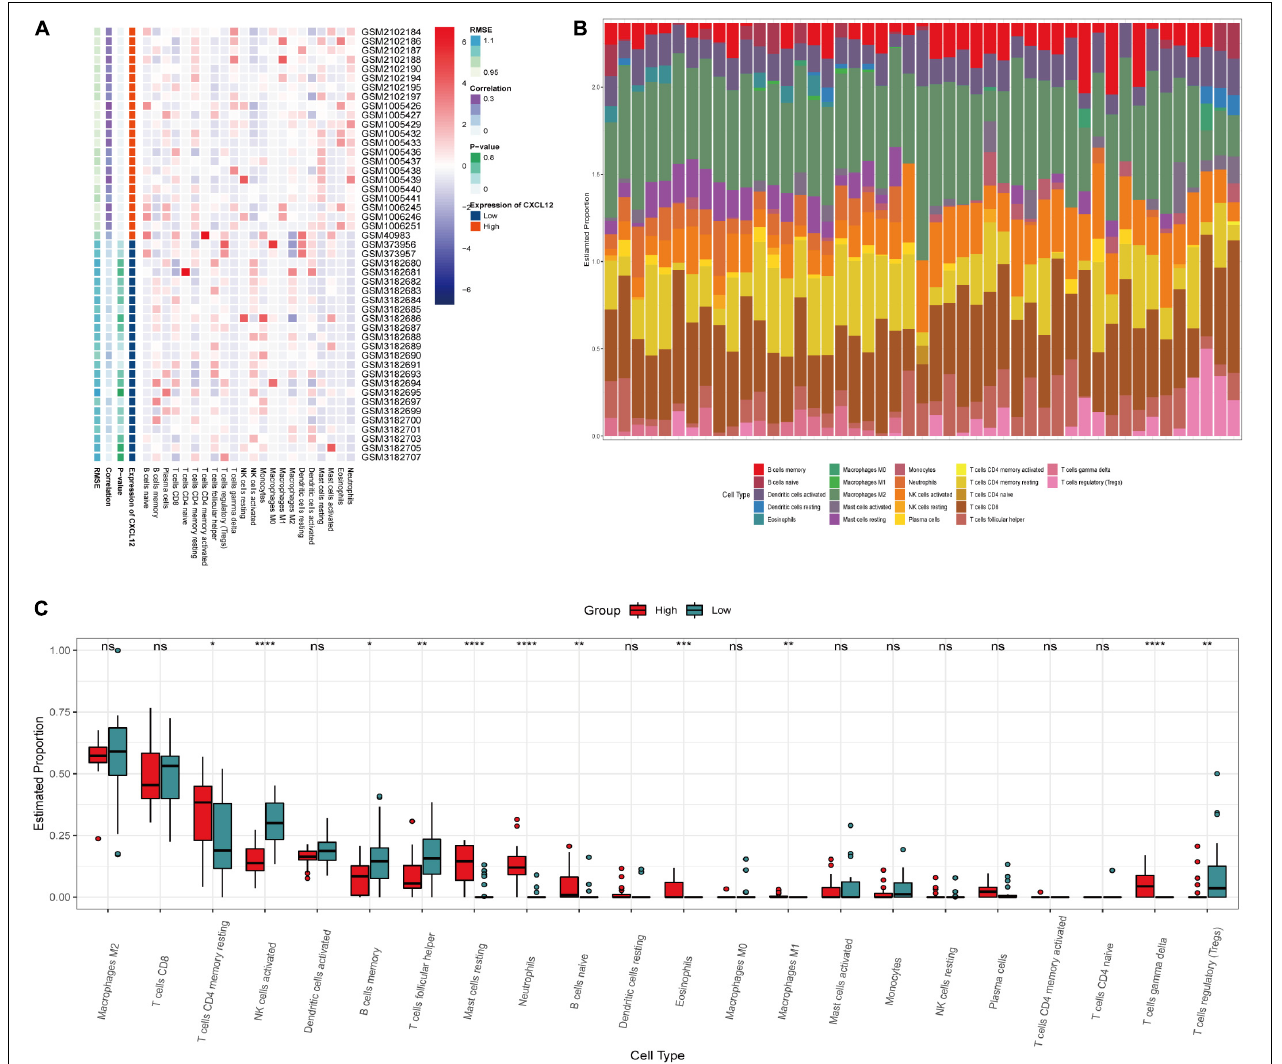
FIGURE 8 | Immune infiltration analysis by CIBERSOT. (A) Heatplot showing the relative infiltration fraction of immune cells in CXCL12-high and CXCL12-low individuals. (B) Relative proportion of immune cell infiltration in CXCL12-high and CXCL12-low individuals. (C) Differences in immune cell infiltration between CXCL12-high and CXCL12-low individuals. * P < 0.05, ** P < 0.01, *** P < 0.001, **** P < 0.0001, ns, no